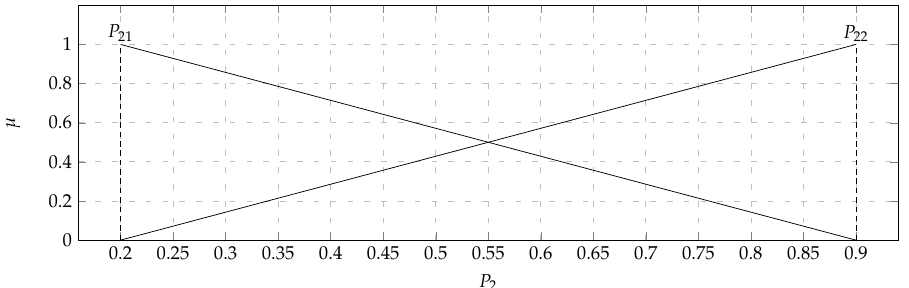
Figure 17. Visualization of Frag gaining assessment model ( P 2 ) and triangular fuzzy numbers 0.2 ( P 21 ) and 0.9 ( P 22